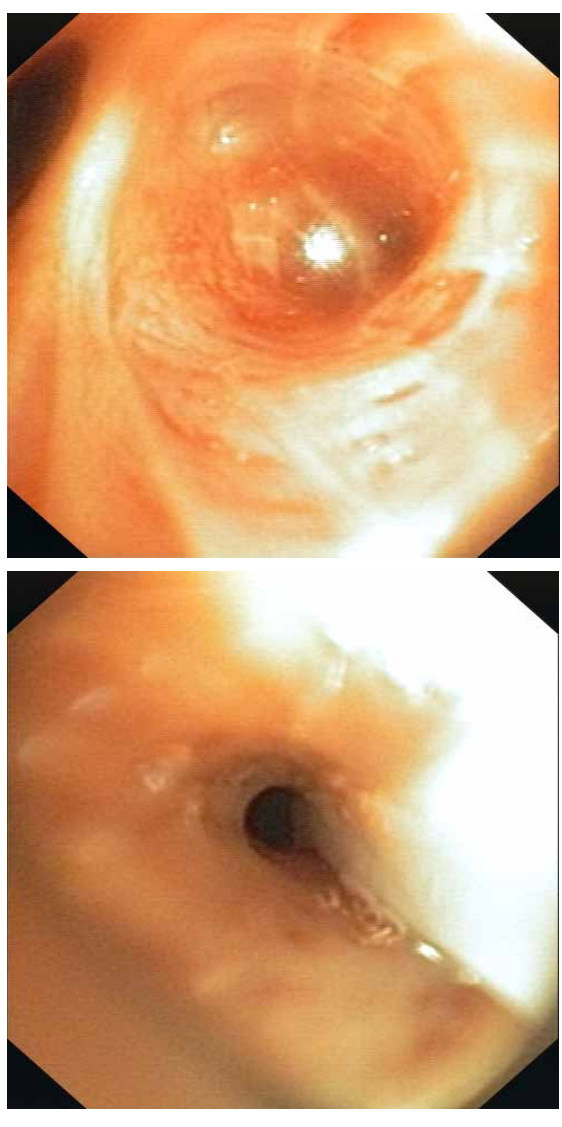
Figure 3. AeriSeal foam Sealants fills the targeted region of right upper lobe segment 1 and left upper lobe segment 1. Table 1. Comparisons of the lung function parameters and 6- minute- walking test before and after endoscopic lung volume Lung function parameter